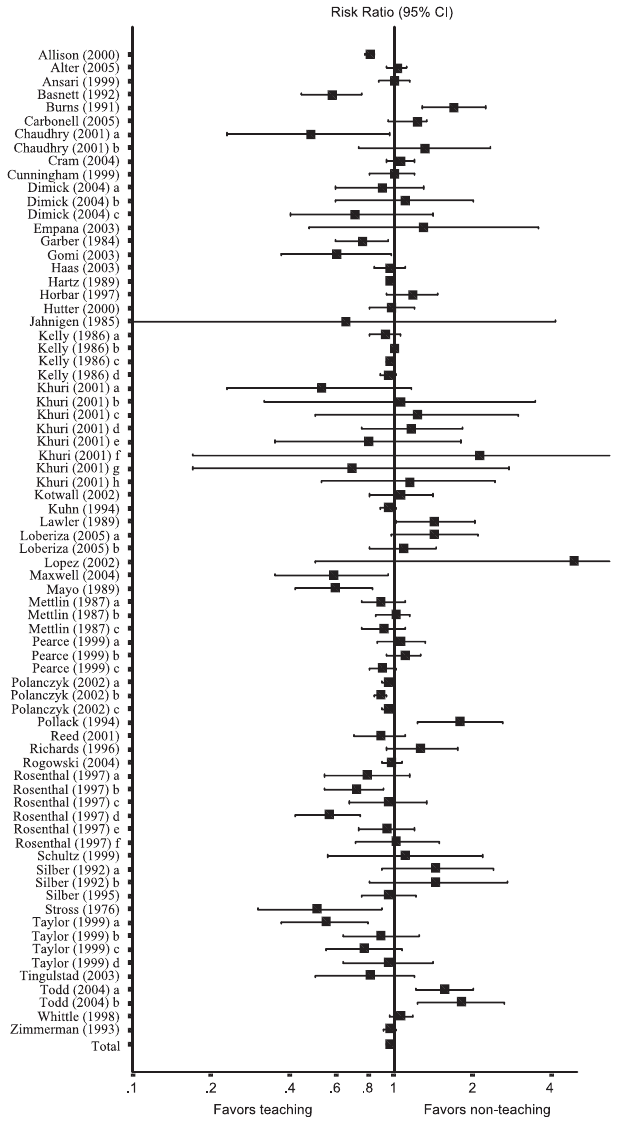
Figure 2. Relative Risk Estimates RR estimates and 95% CIs across studies are shown that address mortality along with summary RR by random effects calculations (Total). The order of the presented estimates is the same as in Table 2. Articles that include estimates on various diagnoses are presented with separate estimates according to type of diagnosis and lettered in the order of Table